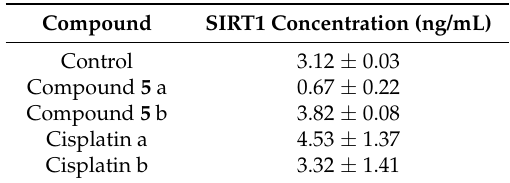
Figure 6. The effects of compound 5 on SIRT1 levels in C6 rat glioma cell line. a: IC 50/2 concentration; b: IC 50 concentration; * significance from control group p < 0.05. Table 5. The effects of compound 5 on SIRT1 Activity.